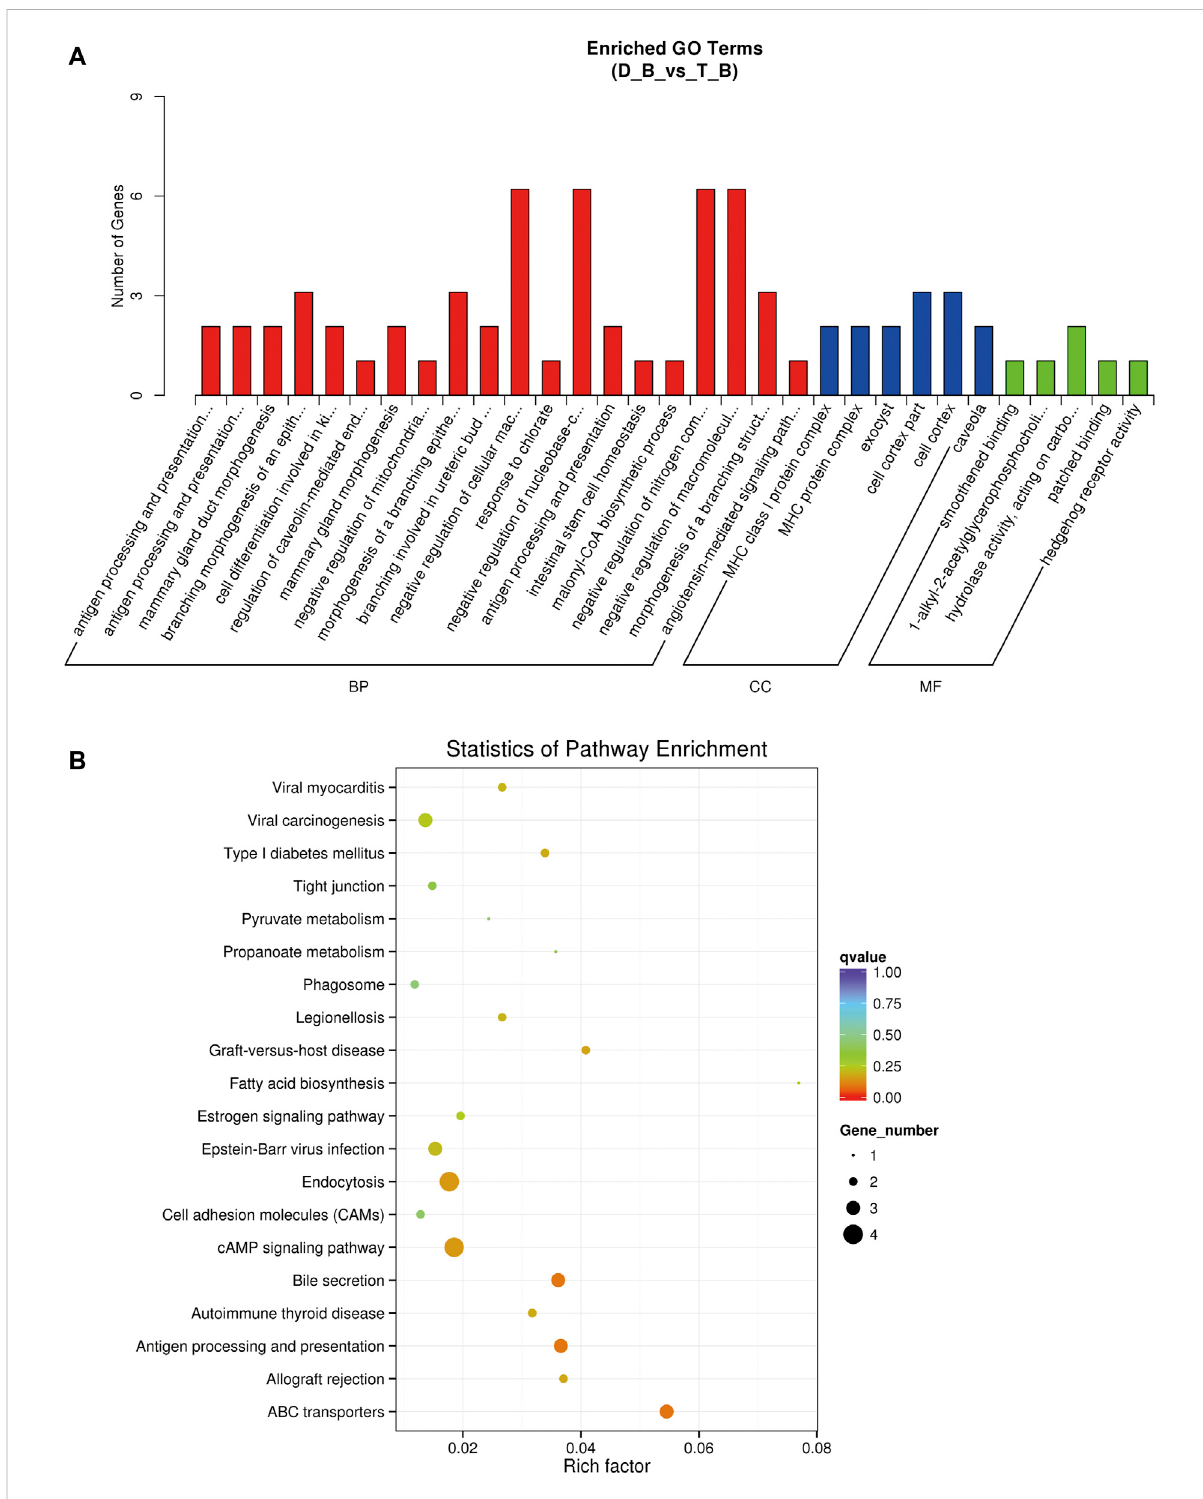
GO and KEGG enrichment analysis in biceps femoris of Tan sheep and Dorper sheep. (A) GO enrichment annotation of mRNAs. (B) KEGG annotation of mRNAs. “ D_B ” is the biceps femoris group of the Dorper sheep. “ T_B ” is the biceps femoris group of the Tan